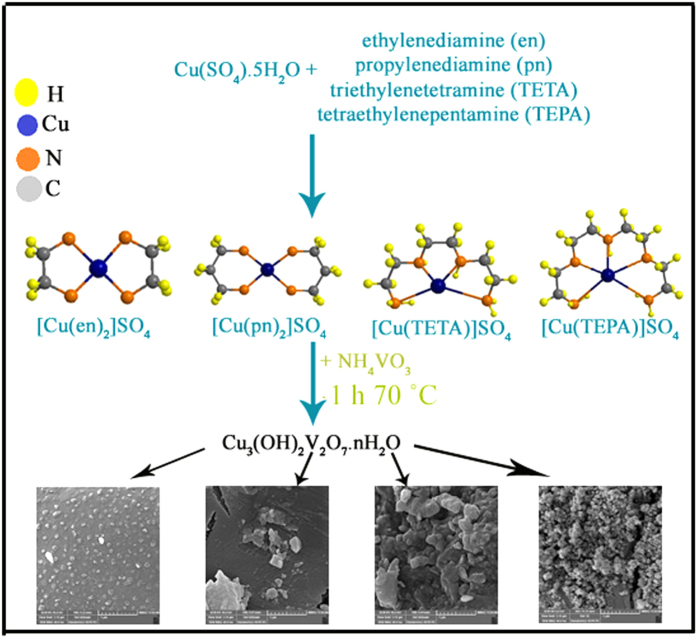
Schematic depiction for the preparation of Cu3V2O7(OH)2(H2O)2 nanoparticles.